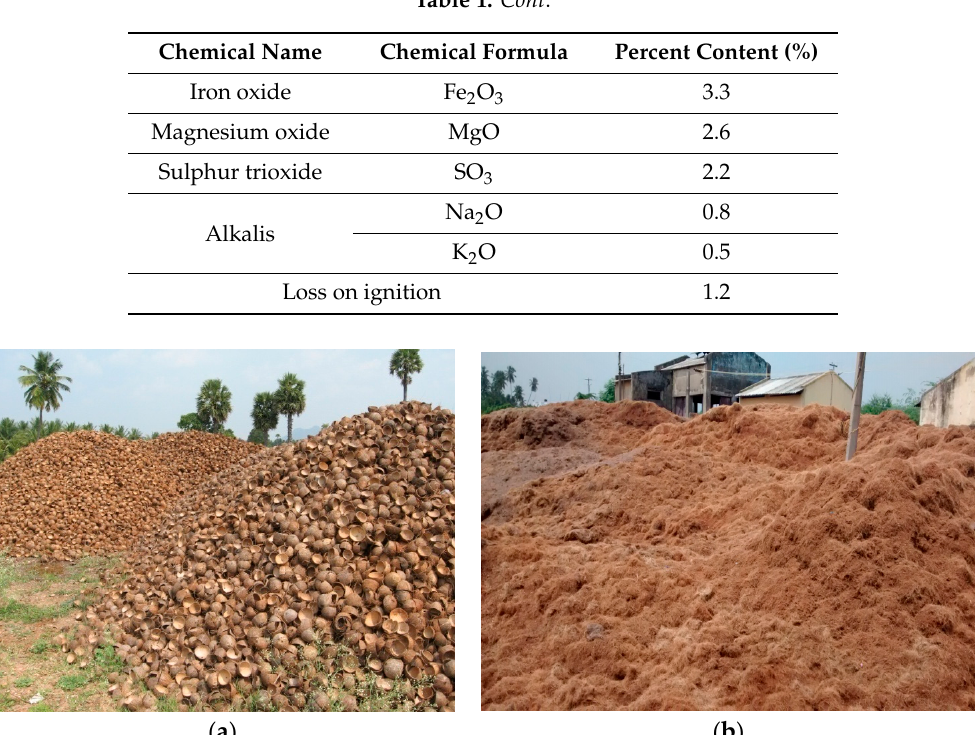
Figure 1. (a) Raw coconut shell (b) coconut fiber at coconut industry. Figure 1. ( a ) Raw coconut shell ( b ) coconut fiber at coconut